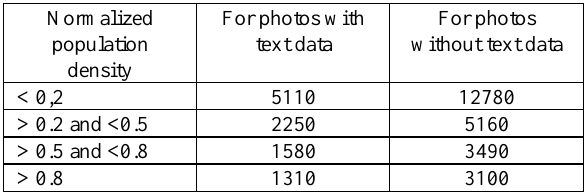
Table 1. Coordinate prediction results for photos containing